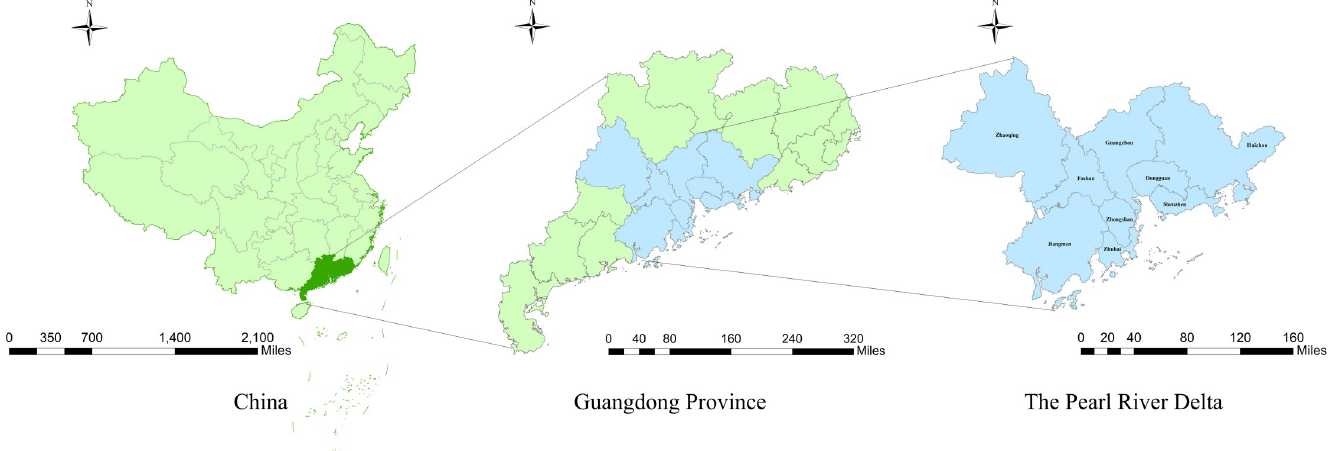
Fig 1. Location of the study area in China. The base layer of the map is from Resource and Environment Science and Data Center (http://www.resdc.cn/data.aspx? DATAID=201).